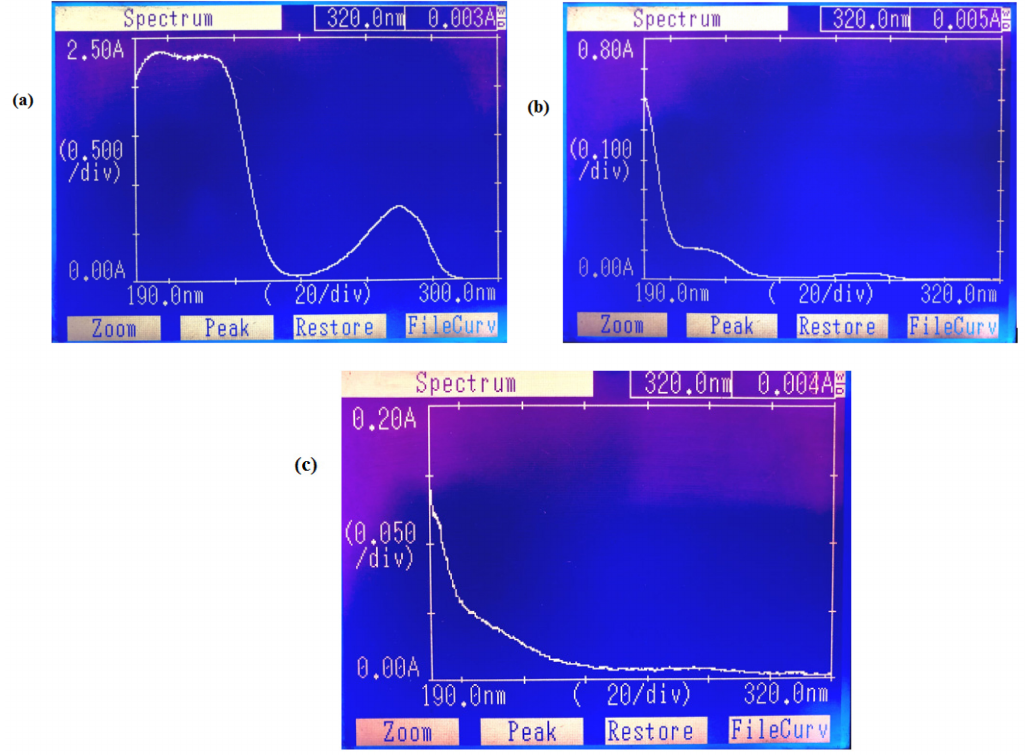
Figure 16. Absorption spectra of the initial aqueous solution of phenol ( a ) and oxidation time ( b ) 1 h ( c ) 2.0